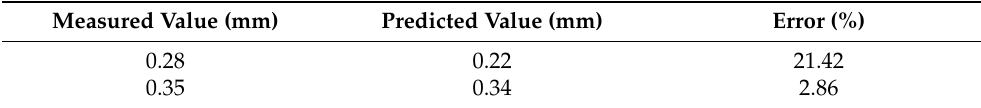
Table 4. Percentage error of g s .